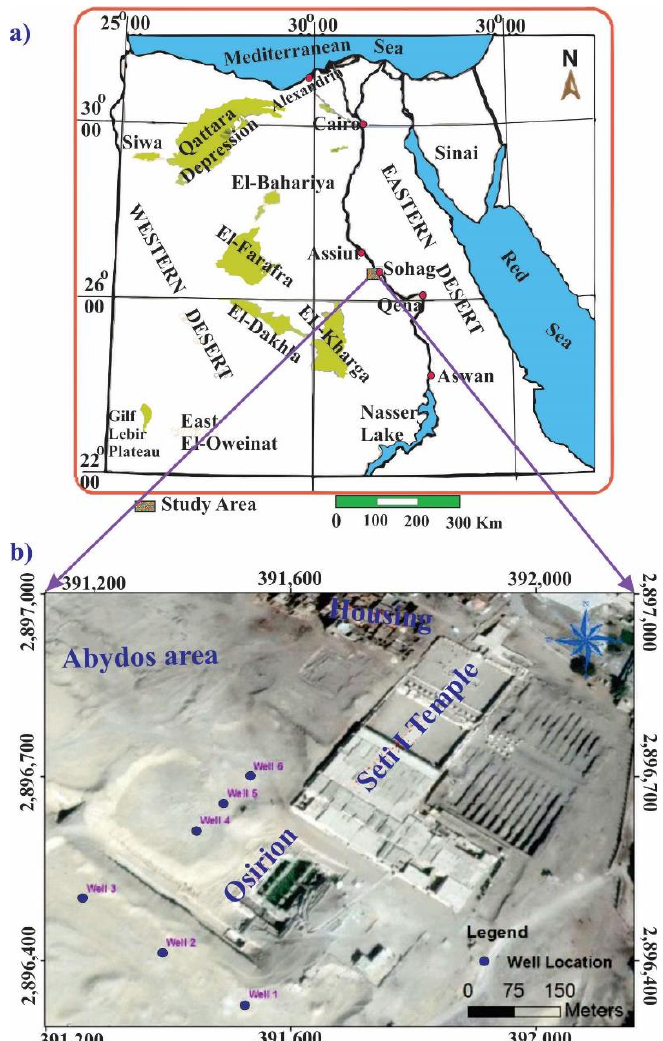
Figure 1. Location map of the Abydos archaeological site, El-Balyana city, Sohag, Egypt, where ( a ) indicates the global map of Egypt, and ( b ) is a detailed map of the Abydos archaeological site that shows the Osirion site and the adjacent